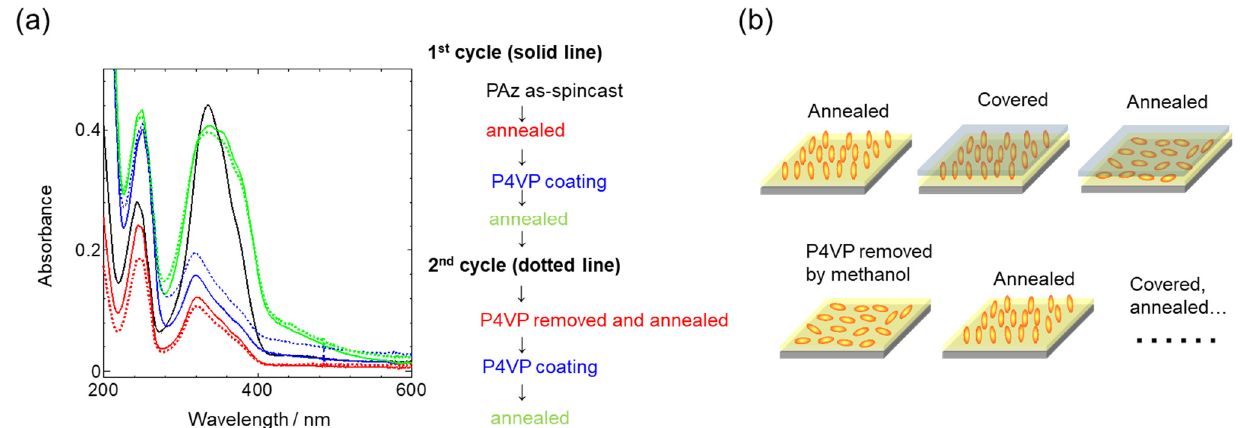
Figure 6. ( a ) UV-visible absorption spectra of PAz film (thickness: 100 nm) in repeated cycles of top-coating and removal of P4VP with annealing. The processes are indicated in colors on the right side, and the colored spectra on the left side correspond to the colored steps. ( b ) Schematic illustration of the mesogen orientation by repeated cycles of coverage and removal of the P4VP top layer.